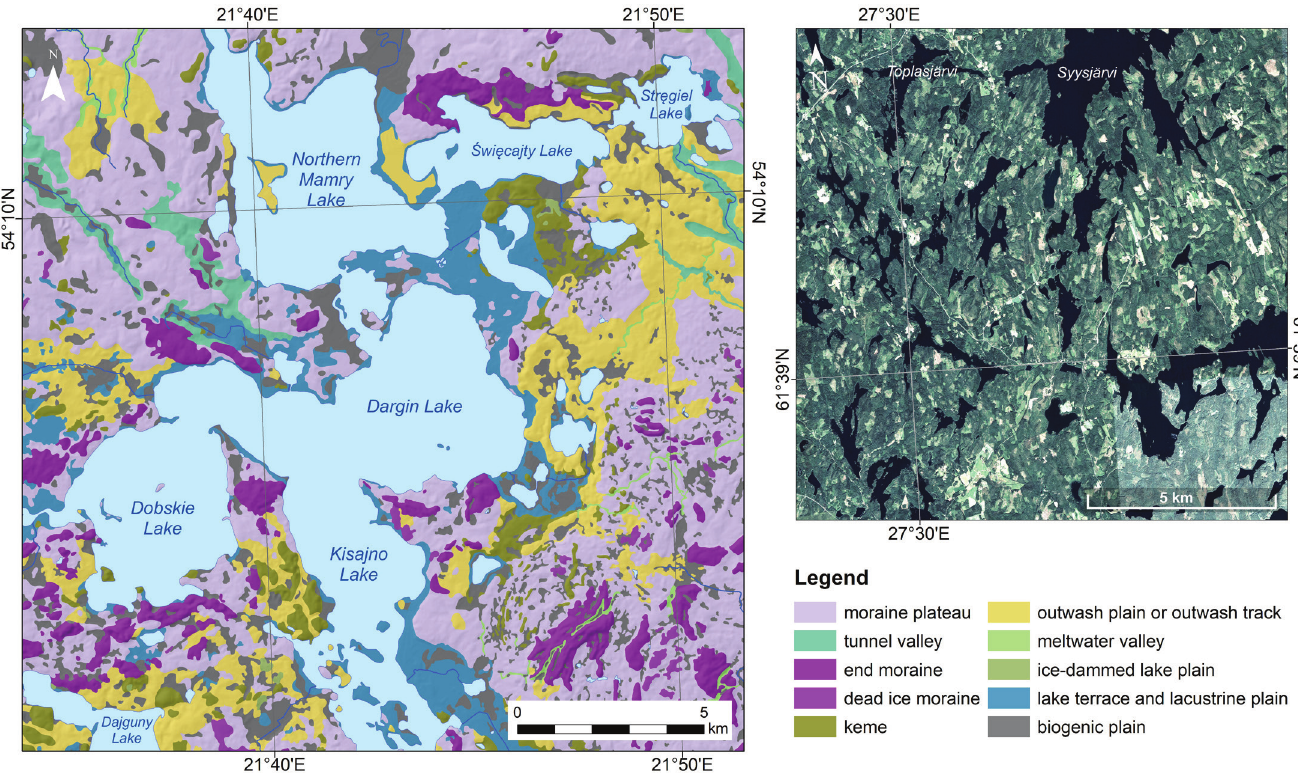
Figure 1. Excerpt from a geomorphological map of the north of the Great Masurian Lakes Region (NE Poland, Kot et al., 2020) with a high lake percentage, and a satellite image of part of the Finnish Lake District with a high lake percentage and high lake density (source: Google Earth